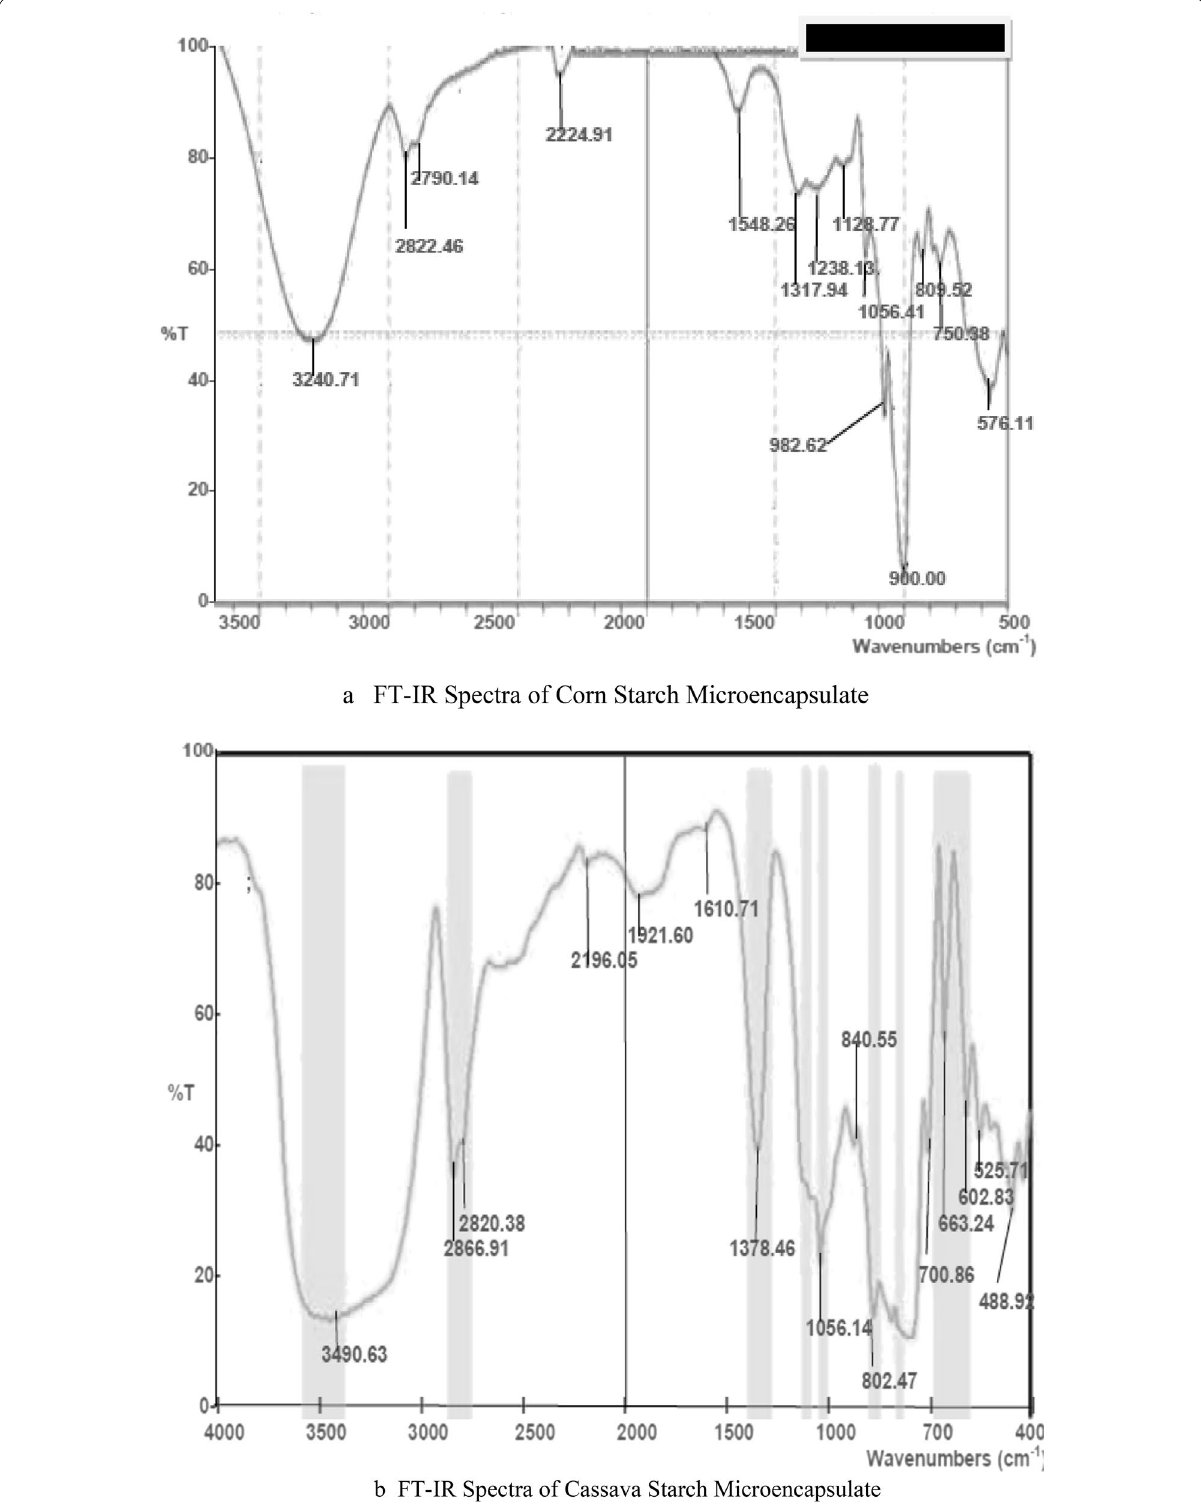
Fig. 4 a FT‑IR spectra of corn starch microencapsulate. b FT‑IR spectra of cassava starch